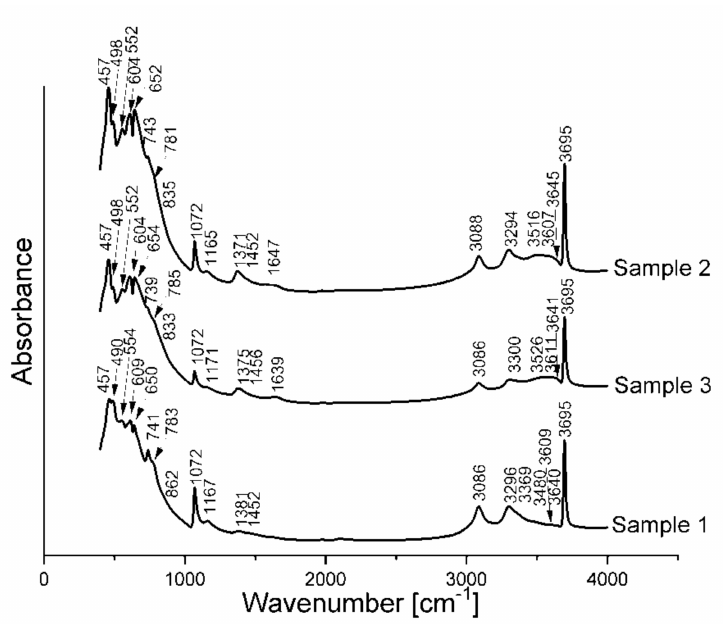
Figure 6. FTIR spectra of studied samples.